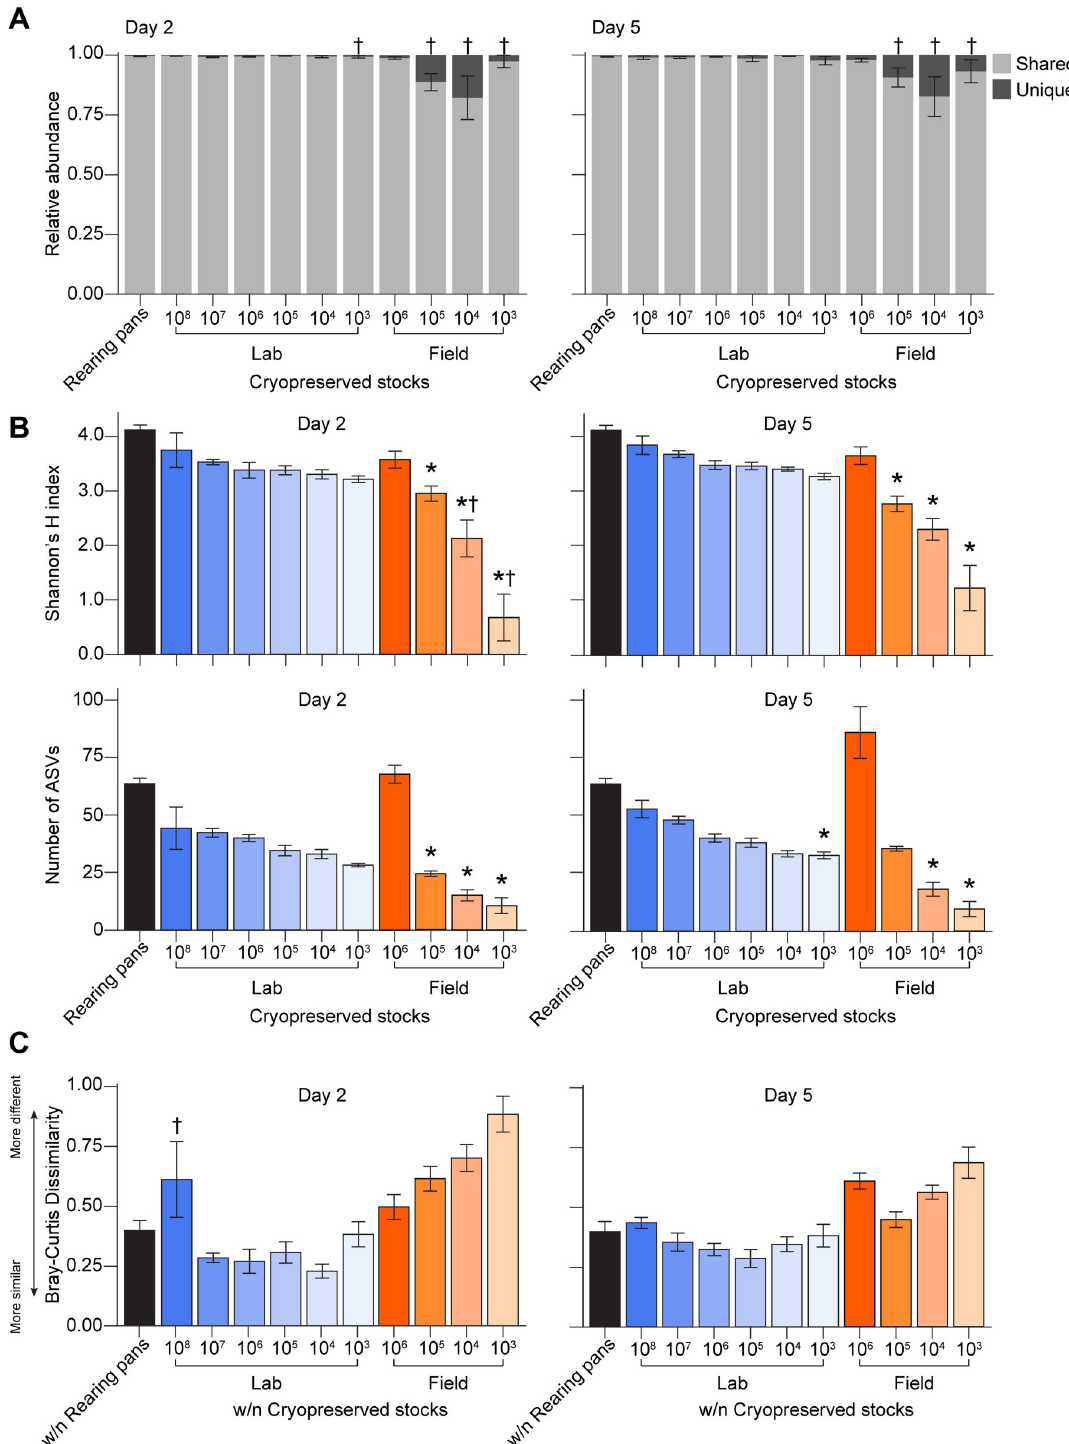
Fig 6. Reproducibility of bacterial communities in replicate microcosms. (A) Average relative abundance of shared microbiota among rearing pan samples and replicates of a given group of experimental microcosms. Daggers (†) indicate comparisons for which the variance of a given group of experimental microcosm samples was significantly higher than that of rearing pan samples (Fligner- Killeen test, P < 0.05). No significant differences in averages were detected between rearing pan samples and any experimental microcosm sample group (Dunn’s test with Bonferroni correction, P > 0.05). (B) Alpha diversity of rearing pans and experimental